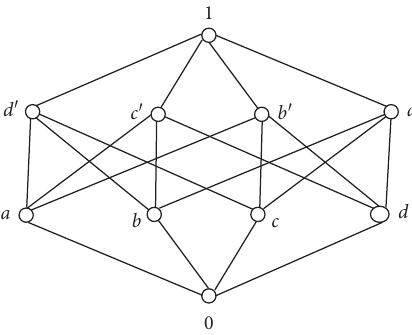
Figure 3: A distributive poset in which every L-fuzzy ideal need not be an L-fuzzy semiprime